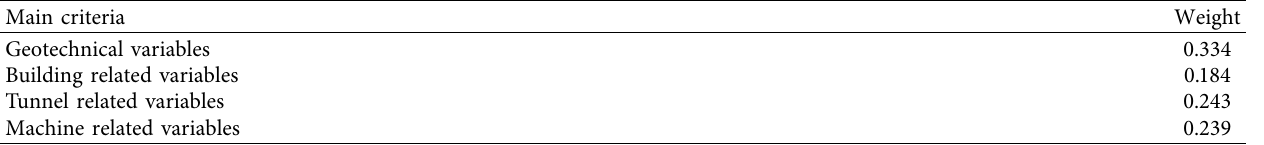
Table 9: Te normalized weights of the main criteria.